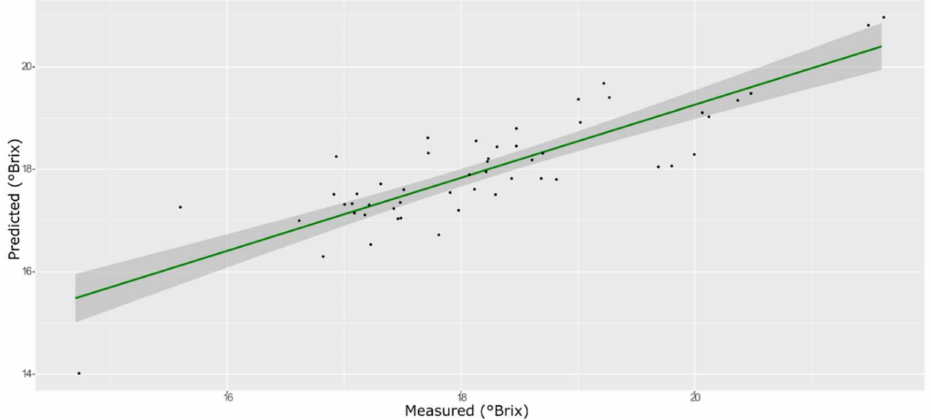
Figure 2. PLS model for TSS on the test set, using the full spectral range.